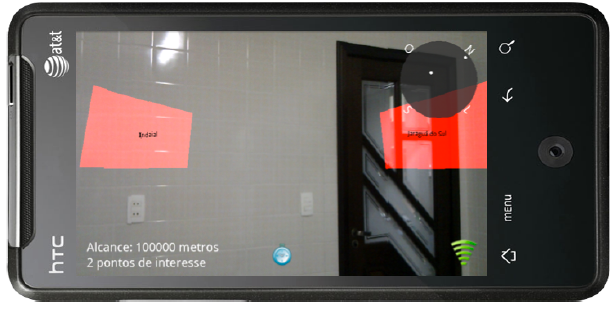
Fig. 6. Device’s camera pointing